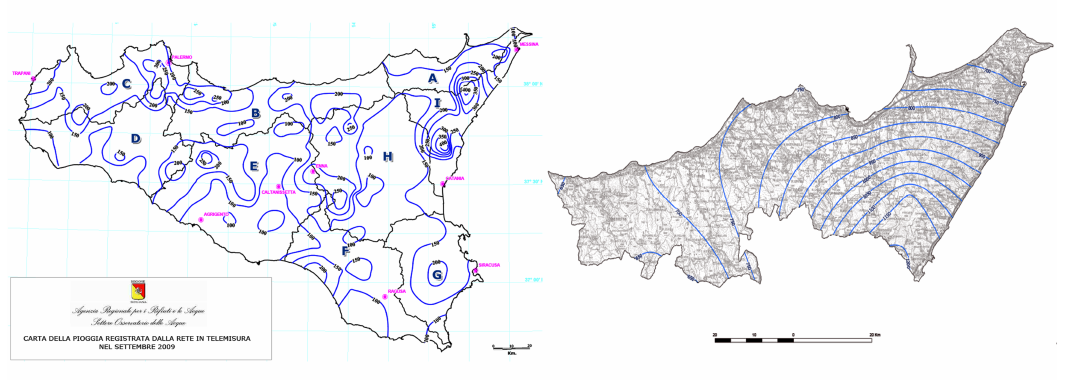
Figure 2. The isohyets in September 2009 and in the year 2009 [19].